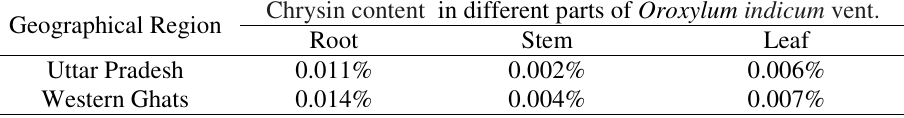
Figure 5 . Overlay of spectra of standard chrysin and chrysin from samples in Oroxylum indicum vent. collected from different geographical regions of India Table 1. Result of chrysin content in Oroxylum indicum vent. from different plant parts collected from different geographical regions of